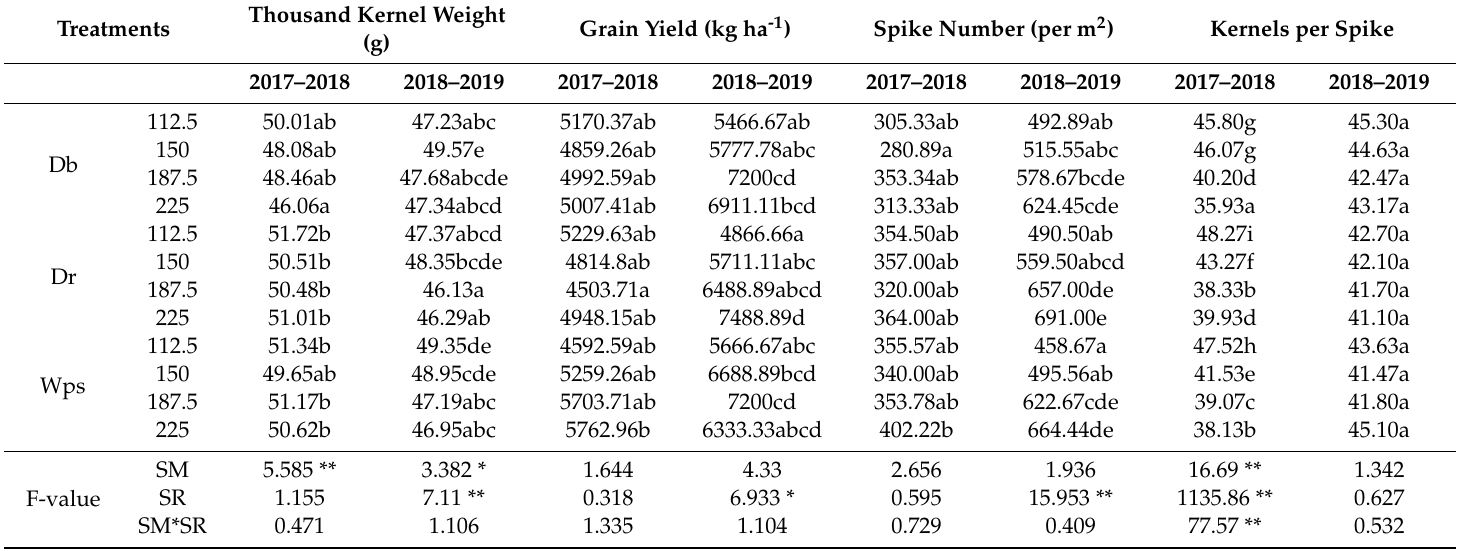
Table 6. The thousand kernel weight, grain yield, spike number per m 2 , and kernel per spike mean values a ff ected by the sowing methods (SM) and seed rate (SR).